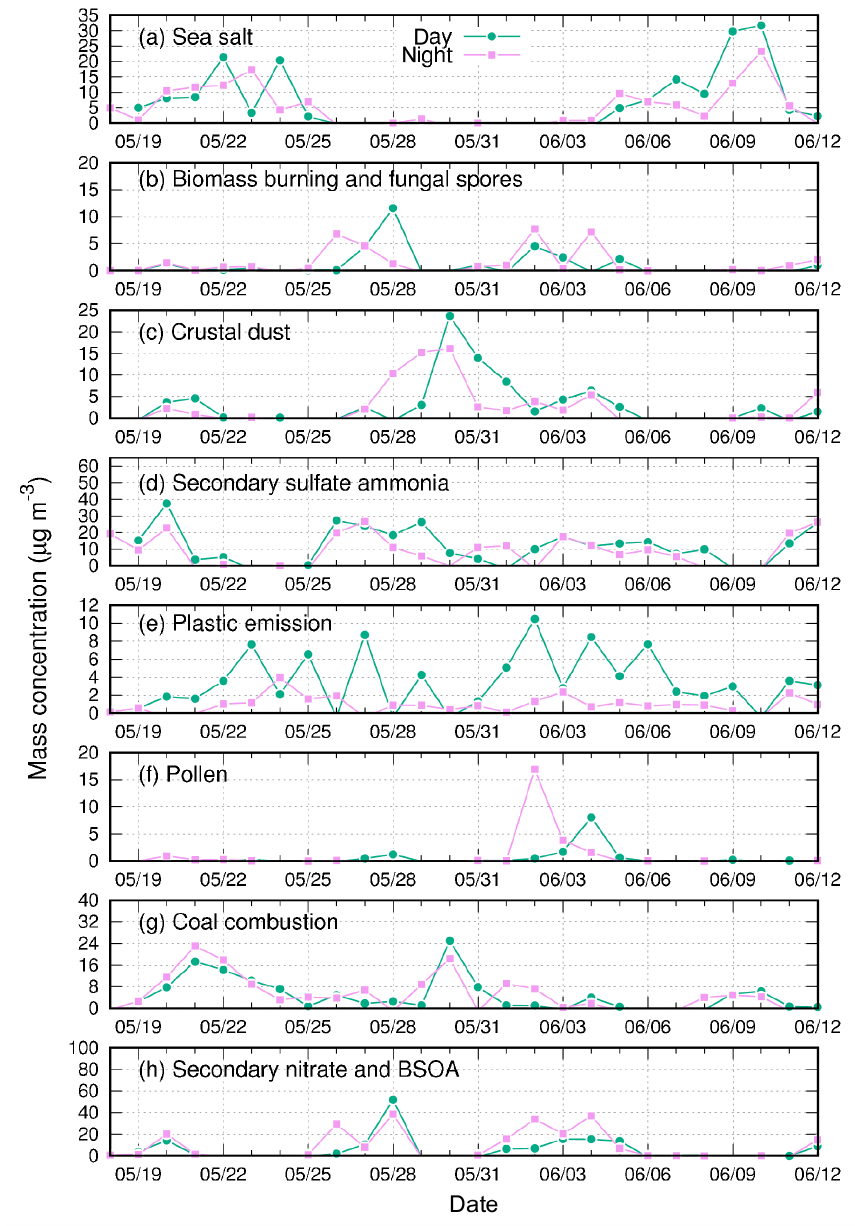
Figure 12. Temporal variation in sources which contributed to marine aerosols (µgm − 3